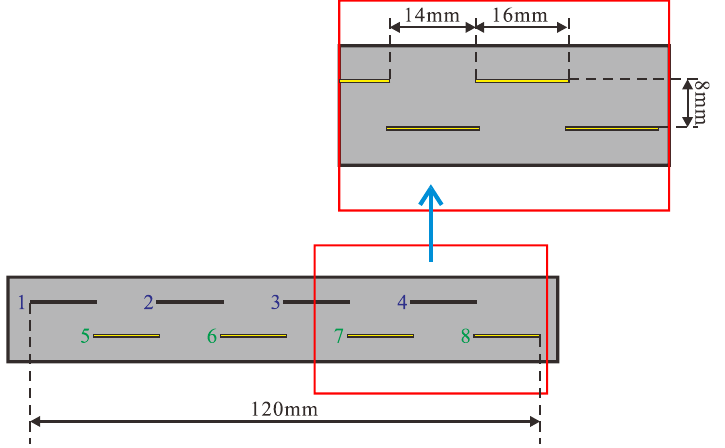
Figure 1. Schematic diagram of multi-slit stitching for ultrawide FOV (slit plane). Figure 2 reveals the instantaneous projections of eight slits on the scene and the dis- persion spectra of each slit after imaging on the focal plane. The scanning mirror moves continuously to cover the gaps between the instantaneous slit images, producing a hyper- spectral image cube across the FOV in geostationary orbit that generates “ image blocks, ” each containing eight separate spectral images. Figure 2 shows two “ image blocks, ” one yellow and one red. After generating the first “ image block ” (yellow), the scanner jumps to the beginning of the following “ image block ” (red). The scan is repeated for the next “ image block ” (red). Each scan cycle can cover an ultrawide FOV of 120 mm, satisfying the requirement to identify high-precision targets from geostationary orbit. The designs based on multi-slit effectively reduce the difficulty and cost of manufacture, in contrast to single-slit incidence imaging spectrometers that excessively rely on large infrared focal plane detectors to obtain large FOVs. Figure 2. Instantaneous projection of a multi-slit LWIR imaging spectrometer (detector plane). The development of a high-precision array multi-slit was carried out to design an LWIR imaging spectrometer with an ultrawide FOV of up to 120 mm. The multi-slit, a critical part of the spectrometer, was made by a new slit manufacturing method using laser-etched indium steel strips and iterated process mapping and design optimization. After finishing the machining, the multi-slit was tested. The results show that the edge